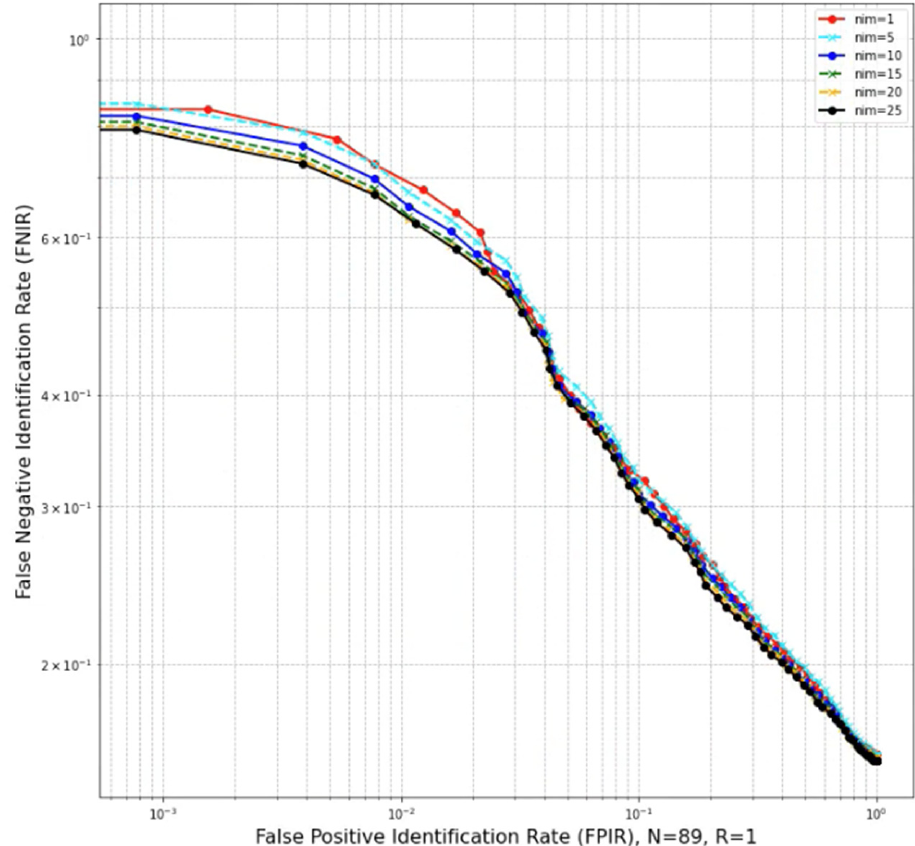
Figure 10. Effect of enrolling multiple images for each identity.